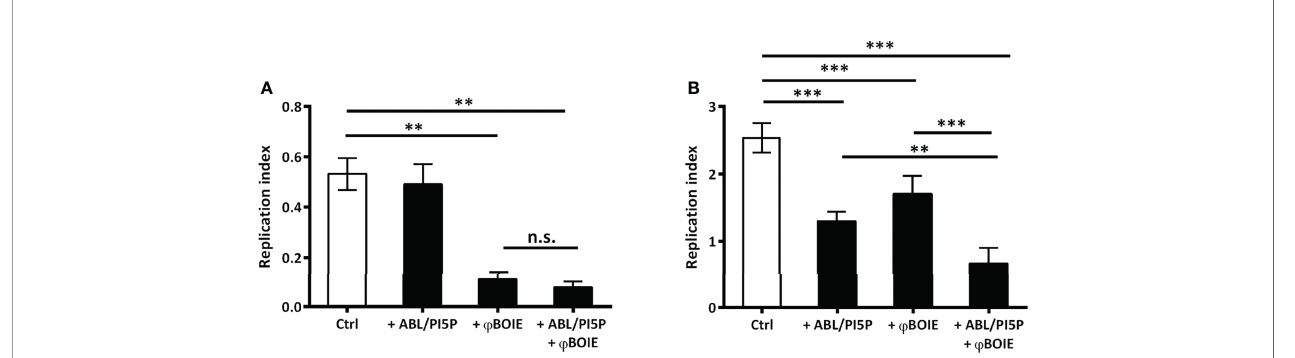
FIGURE 1 | ABL/PI5P- j BO1E combined treatment reduces in an additive manner intracellular growth of KKBO-1. To assess both extracellular (A) and intracellular (B) bacterial growth, dTHP-1 were plated at the concentration of 2.5 × 10 5 cells/well and were infected with KKBO-1 KPC-KP clinical strain, for 1 h at 37°C at a multiplicity of infection (MOI) of 5. Thereafter, extracellular bacilli were collected, adherent cells were lysed with 1% deoxycholate, and both were plated in triplicate on TSA (T0, immediately after 1 h of infection). After, cells were treated with ABL/PI5P and/or j BO1E (MOI 1:0.5 KPC-KP:phage) for further 2 h. Finally, extracellular bacilli were collected and cells were lysed with 1% deoxycholate, samples diluted in PBS-Tween 80 and CFU quanti fi ed by plating bacilli in triplicate on TSA. Replication index was calculated as the ratio between the CFU obtained 2 h after infection in the presence or absence of ABL/PI5P and/or and j BO1E the CFU obtained immediately after infection (T0), before the addition of the stimuli. The results are shown as mean ± standard deviation of the values obtained from triplicate of each condition. **p < 0.01, ***p < 0.001, and n.s. “ not signi fi cant ” by Student ’ s